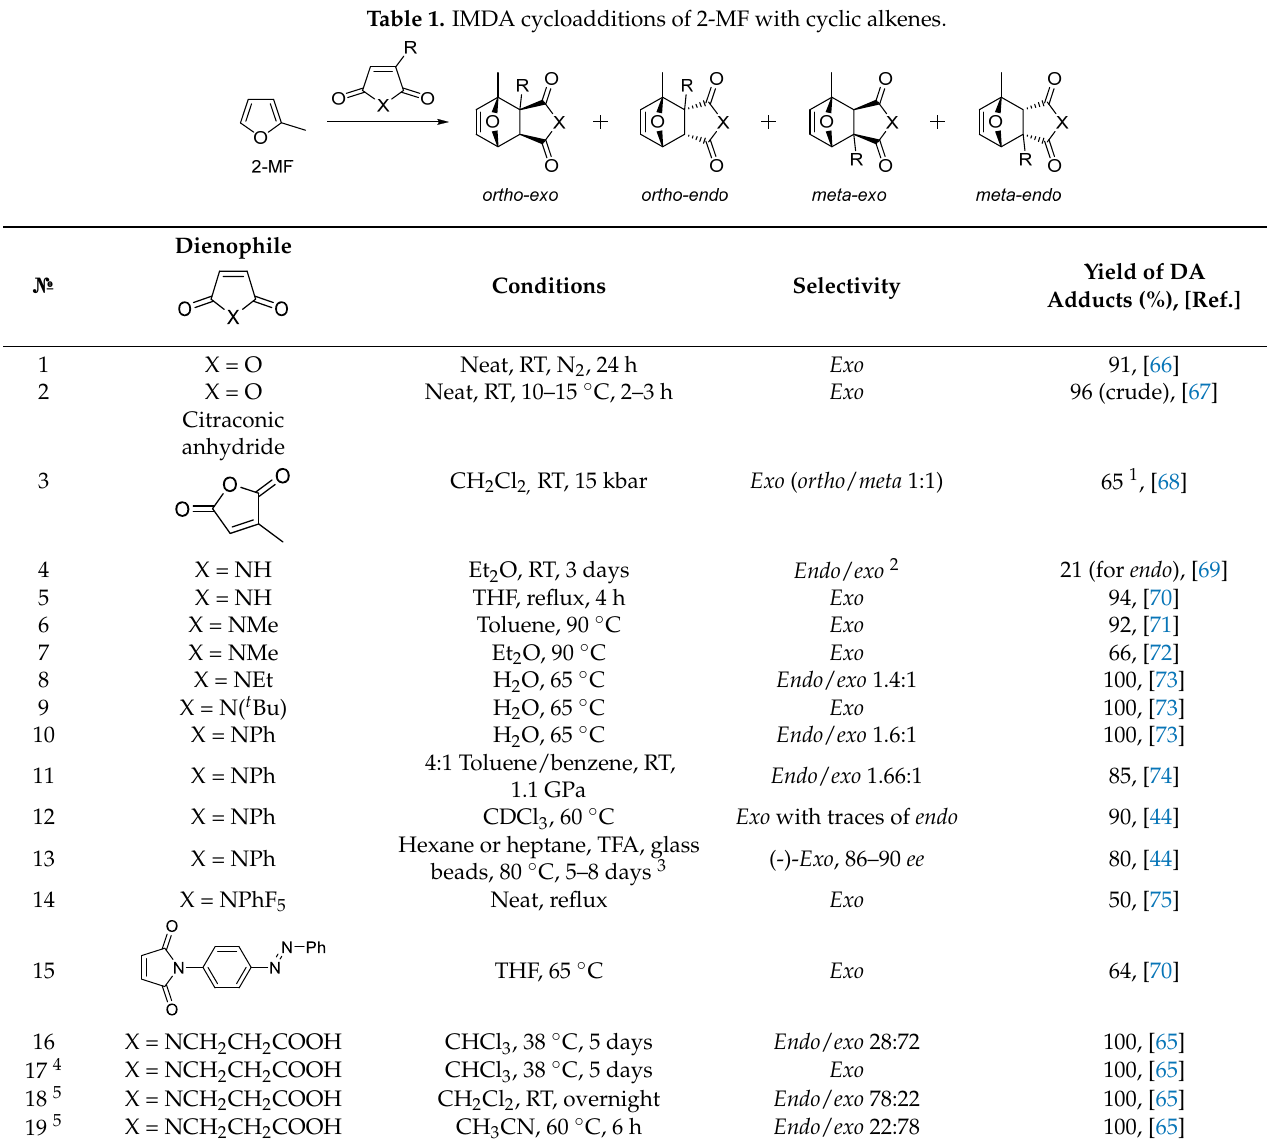
Table 1. IMDA cycloadditions of 2-MF with cyclic alkenes.